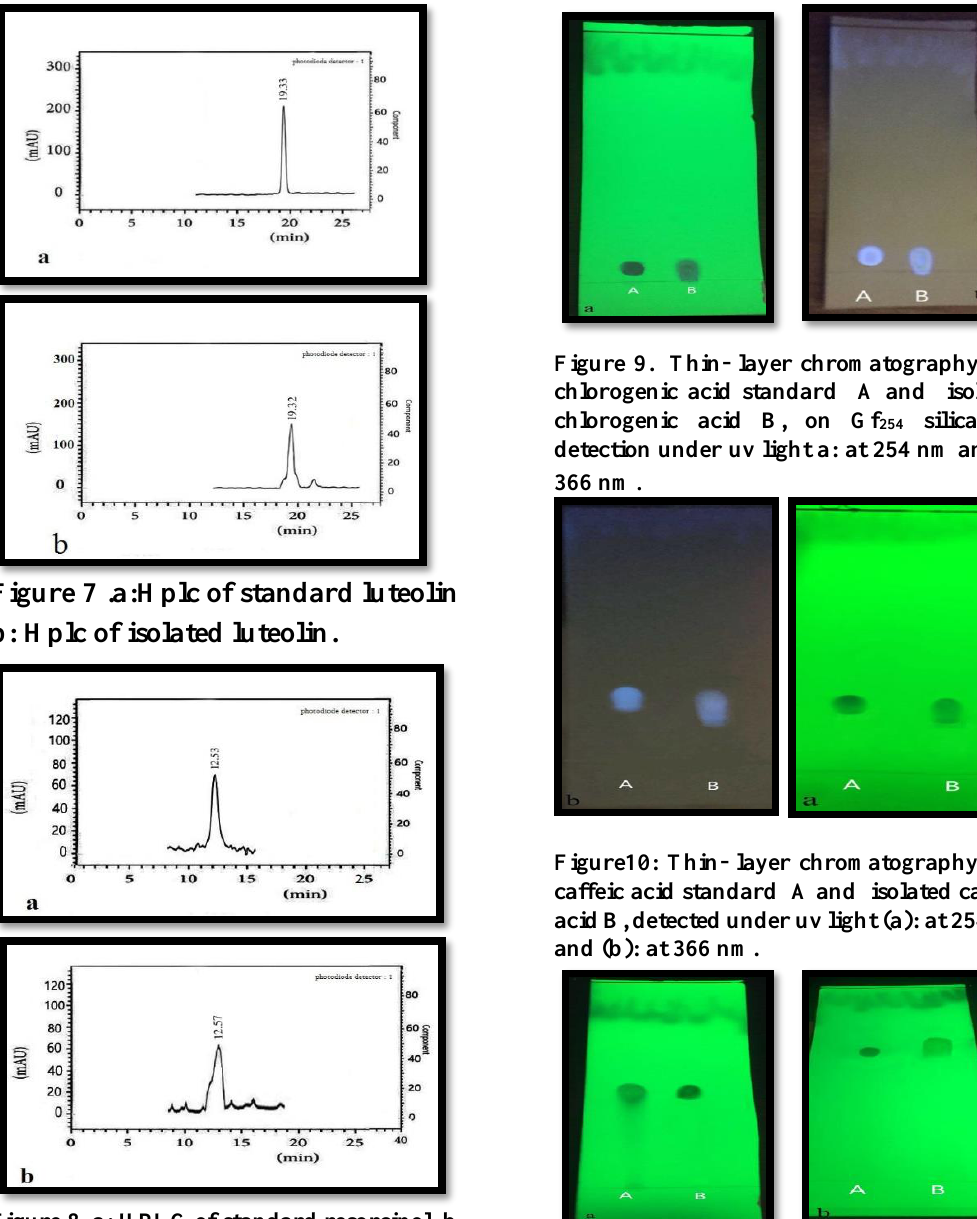
Figure 8. a: HPLC of standard resorcinol b : HPLC of isolated resorcinol TLC for the isolated compounds This was performed to insure the purity of the isolated compound which were isolated by scraping the isolate bands of the preparative TLC.